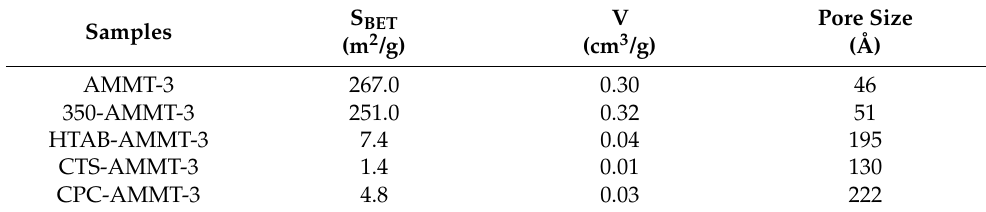
Table 4. Texture properties of the modified